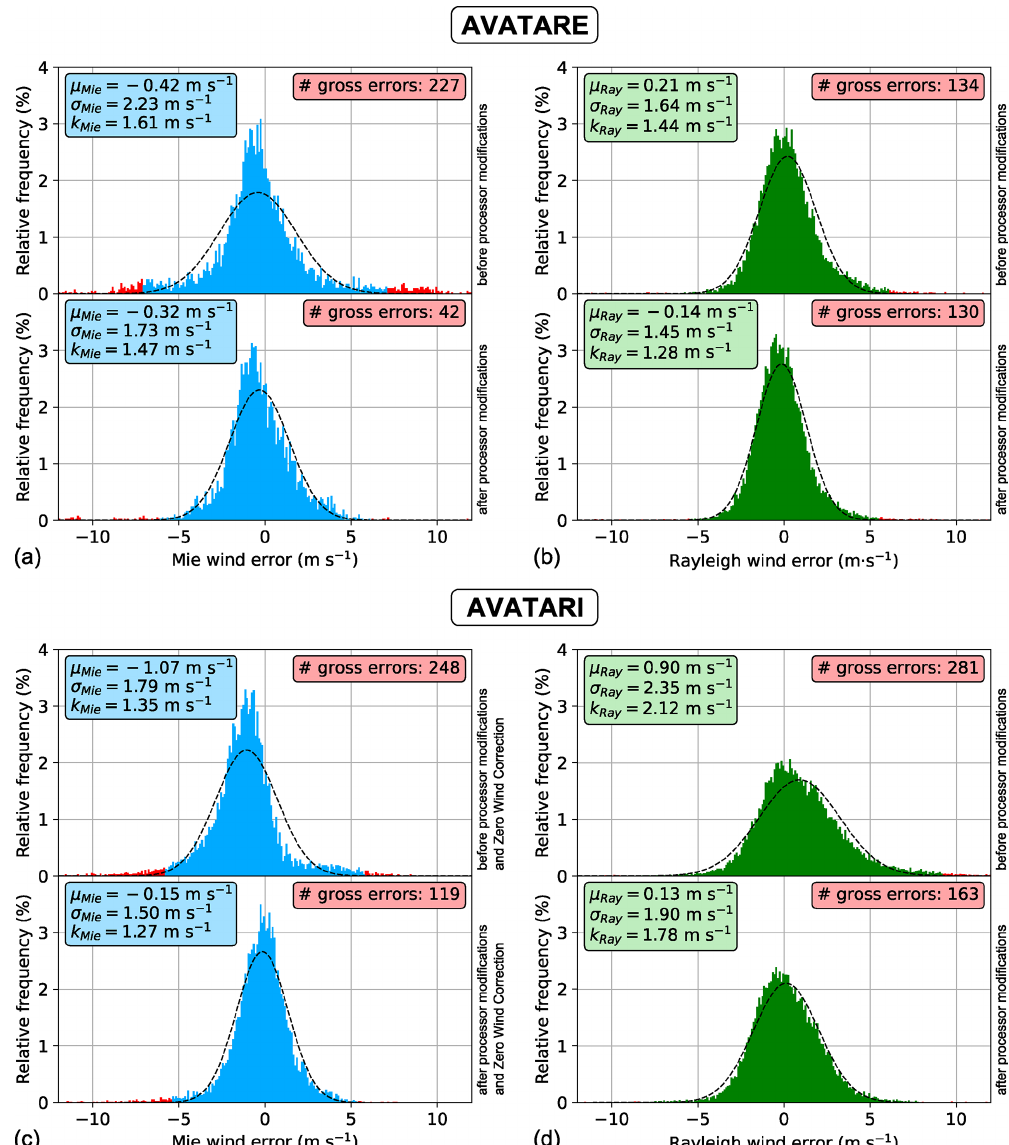
Figure 11. Probability density functions for the A2D Mie (a) and Rayleigh (b) wind error with respect to the 2µm DWL for the entire AVATARE campaign before (top plot in each panel) and after (bottom plot) the applied retrieval modifications. Gross errors (see the definition in the text) are marked in red. The dashed lines represent Gaussian fits. The insets summarize the mean values µ , standard deviations σ , and scaled MAD k calculated for the respective datasets. The corresponding PDFs of the A2D Mie and Rayleigh wind error for the AVATARI dataset are provided in panels (c) and (d) ,